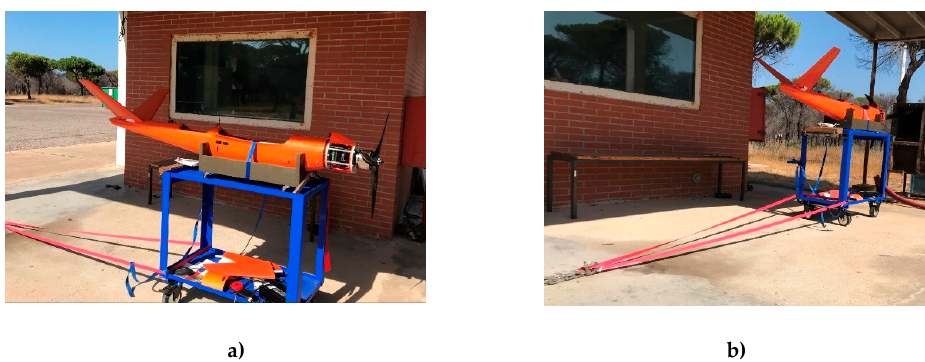
Figure 13. Modified electric ALO in thrust test bench. ( a ) lateral view, ( b ) stern view